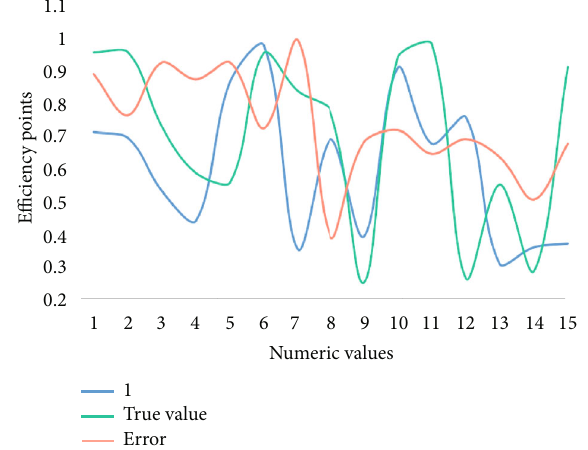
Figure 6: Land use reasoning data analysis diagram.